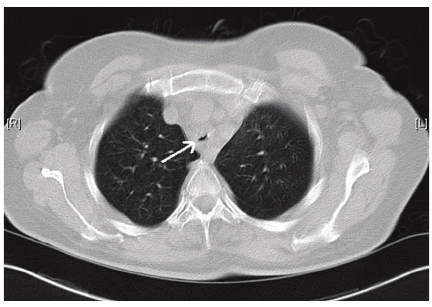
Figure 1: CT scan revealing tracheal stenosis.